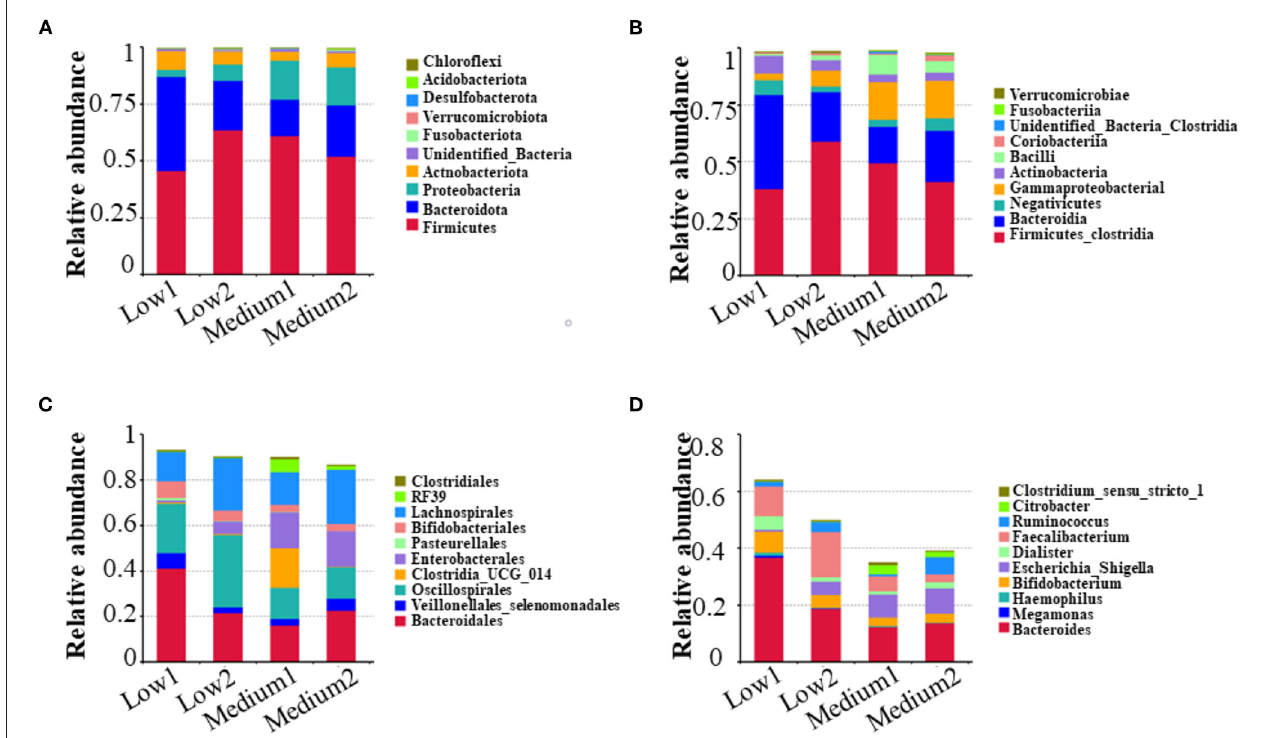
FIGURE 6 | Analysis and comparison of relative abundance of top 10 before and after the intervention in the Low and the Medium groups at phylum, class, order, and genus level. The higher the relative proportion, the more abundance in the community at different biological classification level. (A) means phylum level; (B) means class level; (C) means order level; and (D) means genus